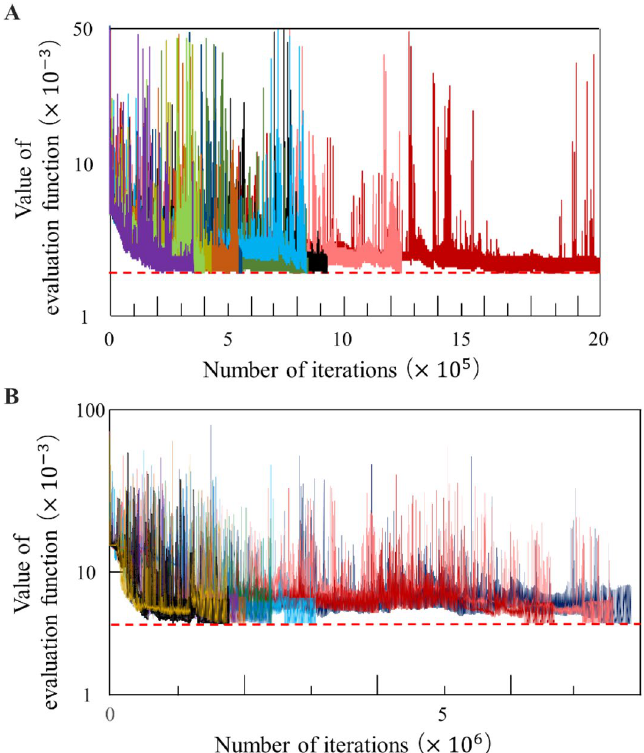
Figure 5. Learning curve. The values of evaluation function converged through the BPTT learning algorithm for all five trials. The dotted red line represents the error tolerance. ( A ) Learning curve obtained from ten training trials using the teacher data generated from Eqs. (9)–(11). ( B ) Learning curve obtained from ten training trials using the teacher data generated from the measured muscle activity.